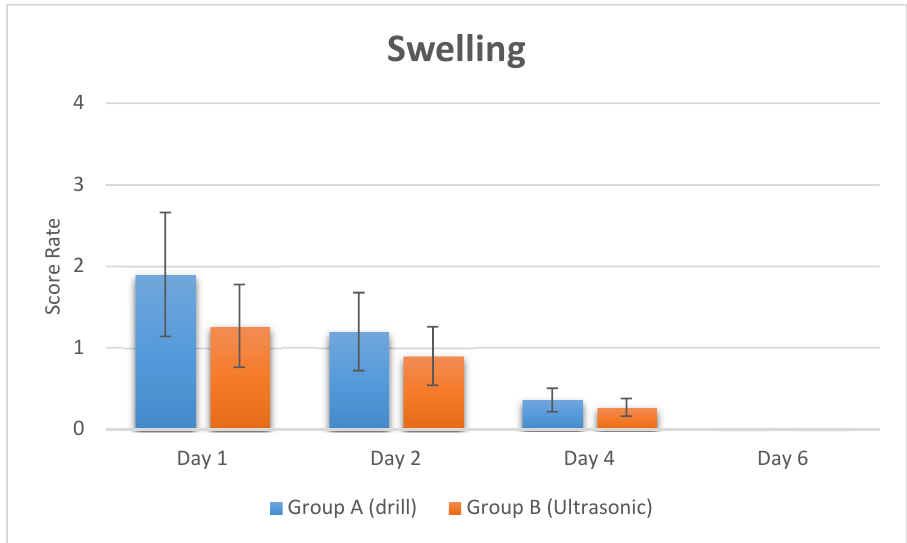
Figure 2. Swelling in post-operative times recorded by swelling score after implant treatment by Verbal rating scales (VRS). Table 1. Summary of recording of VAS score and swelling score at different times after surgery. The VAS pain score and swelling score (VRS) were significantly decreased in the ultrasonic surgery group.